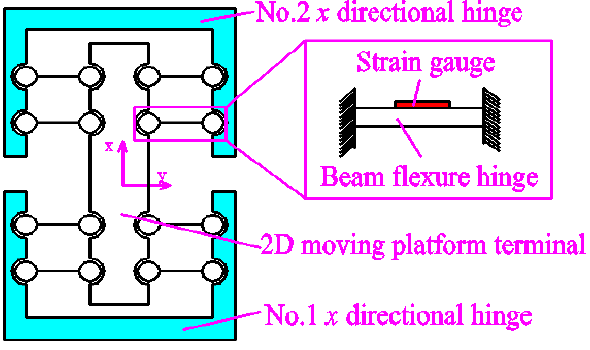
Figure 7. The x-guidance element principle.